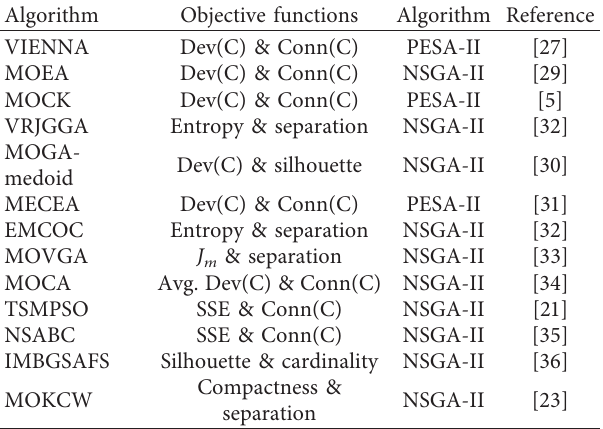
Table 1: Summary of the popular multi-objective metaheuristic algorithms for data clustering with their related